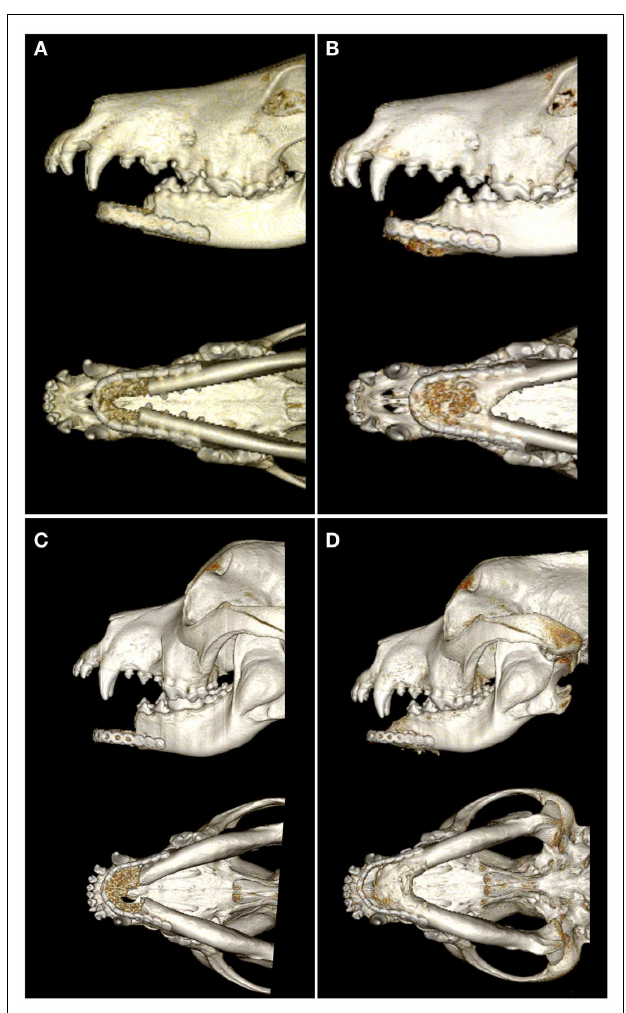
FIGURE 5 | Lateral and ventral views of 3D volume renderings created from the CT images immediately postoperatively (A,C) and 6months after surgery (B,D) . Note the new bone formation in the intermandibular space and bridging the ostectomy sites of both patients 6months after